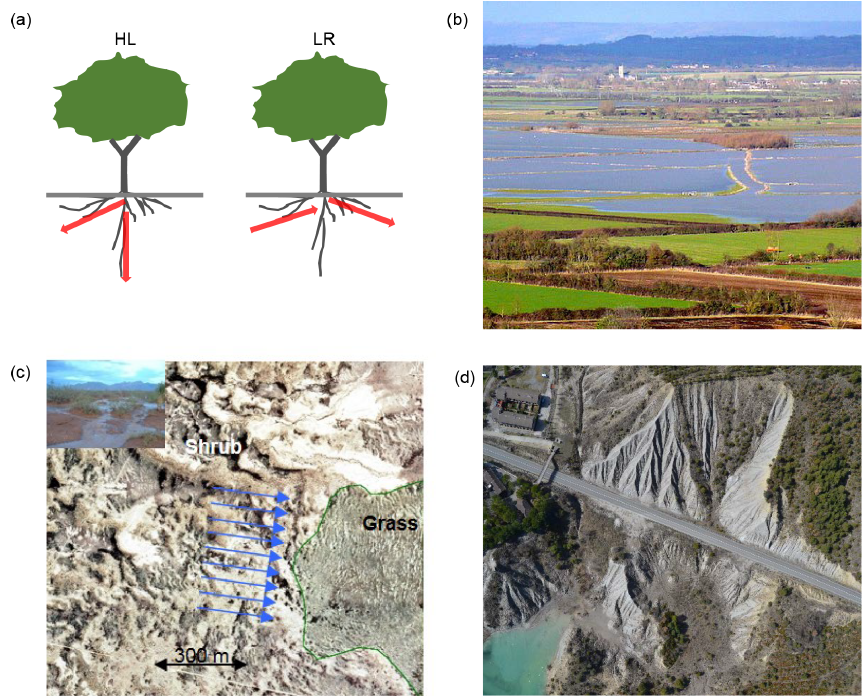
Figure 1. Example of connectivity snapshot images of scientists discussing the effects of vegetation type on water flow. (a) Plant-ecological snapshot: different types of hydraulic redistribution (HR); hydraulic lift (HL), the most commonly observed type of HR, takes place when shallow soil layers are drier than deep layers, and lateral redistribution (LR) is the horizontal redistribution of soil water between soil layers at the same depth but with different water potentials (after Prieto et al., 2012). (b) Hydrological snapshot: flooding on West Moor, Somerset (Mykura, 2018, creative commons licence). (c) Erosion snapshot: water and erosion modelling across a vegetation boundary from a shrubland (top, marked shrub in the picture) with high hydrological connectivity to a grassland (bottom left) with low hydrological connectivity (Mueller et al., 2007) and arrows indicating the direction of water flow. (d) Geomorphological snapshot: effects of vegetation (and anthropogenic structures) on channel initiation, drainage density and landform evolution (Vericat, 2015, with permission).